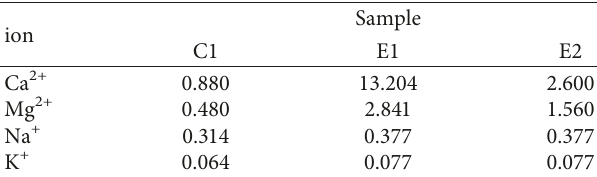
Table 2: Concentration (cmol/kg) of exchangeable ions in the clay